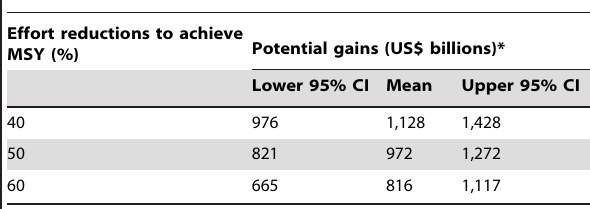
Table 7. Sensitivity of present value potential gain in resource rent from rebuilding to parameter